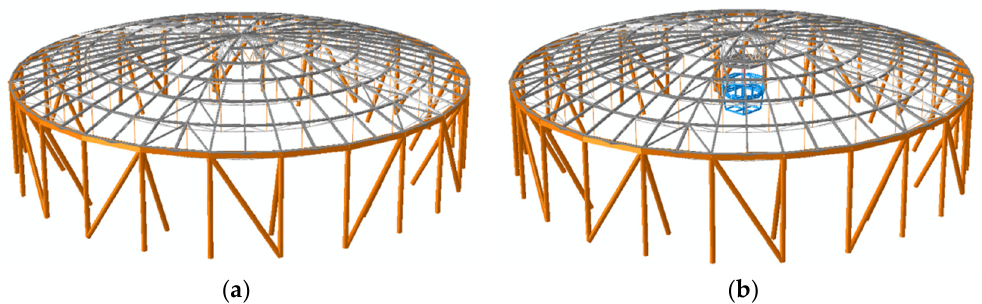
Figure 10. First 15-order natural frequencies of the two overall models.